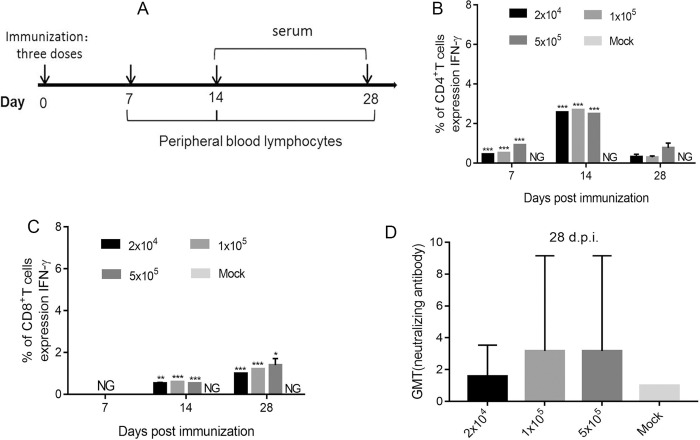
The rhesus monkeys immunized with mutant M6 could induce significant adaptive immune response.(A) Design of the monkey dose-dependent experiment. (B, C) T cell responses to three doses of M6 immunization. Peripheral blood lymphocytes were isolated from immunized monkeys at 7,14 and 28 d.p.i. and stimulated with PMA, ionomycin and Golgi stop, followed by intracellular staining for IFN-γ. (B) Percentages of CD4+ T cells that were producing IFN-γ. (C) Percentages of CD8+ T cells that were producing IFN-γ. (D) Neutralizing capability of the antibodies against HSV1 in mice immunized with HSV1 M6 (three doses) or PBS. The geometric mean titers (GMTs) of the neutralization antibodies were measured by a neutralization test as described in “Materials and Methods.” The GMT values for the negative control (PBS) groups were all <2.